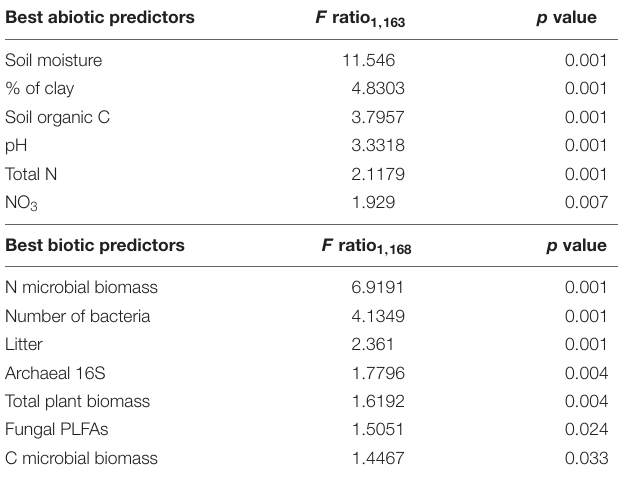
TABLE 3 | ANOVA results of the most parsimonious RDA model including selected edaphic and biotic